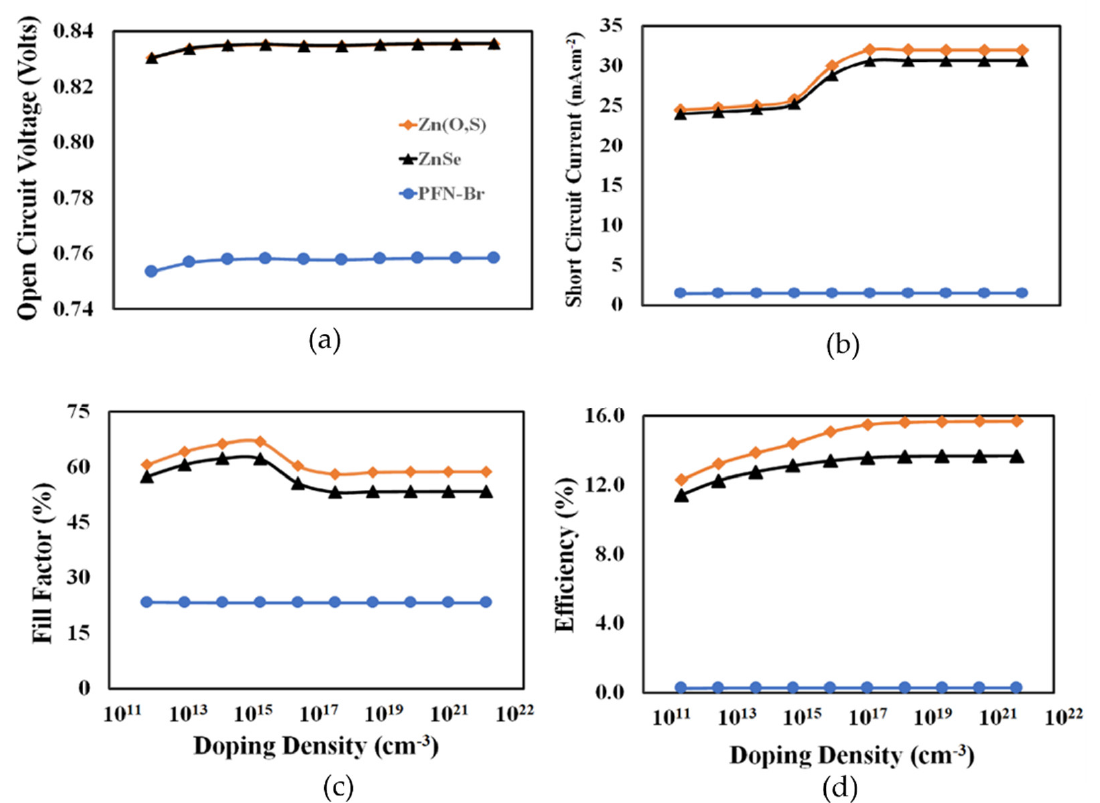
Figure Figure 4. The photovoltaic parameters of ( a ) open-circuit voltage, ( b ) short-circuit current, ( c ) fill factor, and ( d ) power conversion efficiency as a function of the PEDOT:PSS doping density for ITO/Zn(O,S)/PTB7:PC 70 BM/PEDOT:PSS/Au, ITO/ZnSe/PTB7:PC 70 BM/PEDOT:PSS/Au, ITO/PFN- Br/PTB7:PC 70 BM/PEDOT:PSS/Au, respectively.